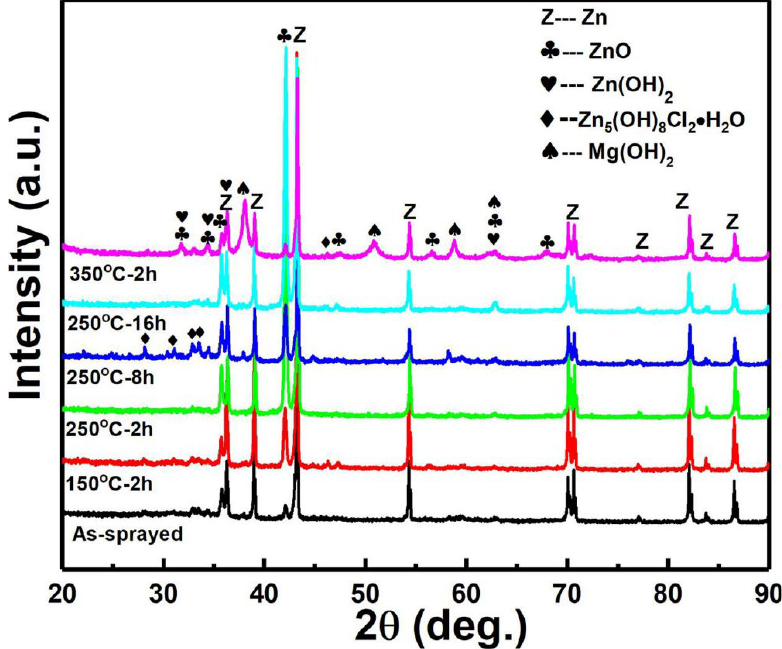
Figure 10. XRD patterns of different Zn coatings after immersion for 14 days.